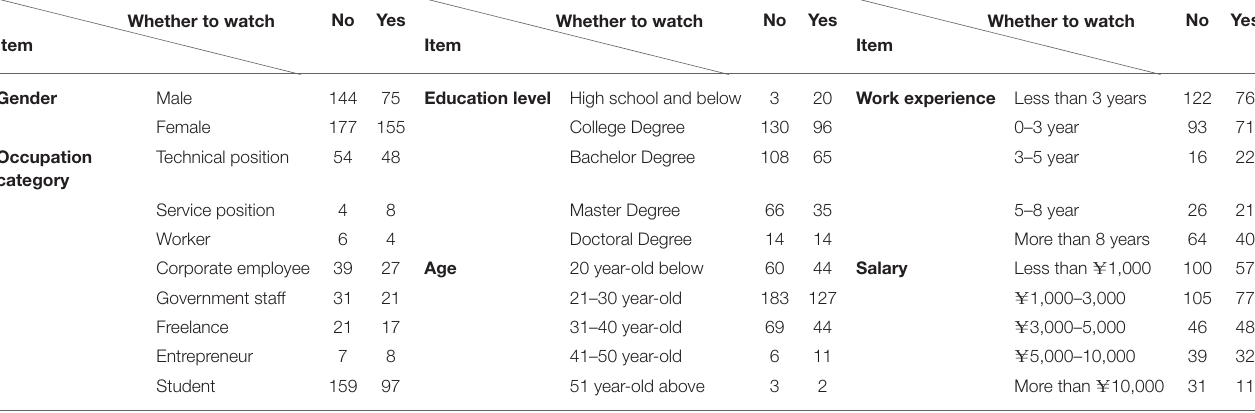
TABLE 1 | Demographic information of respondents ( N =